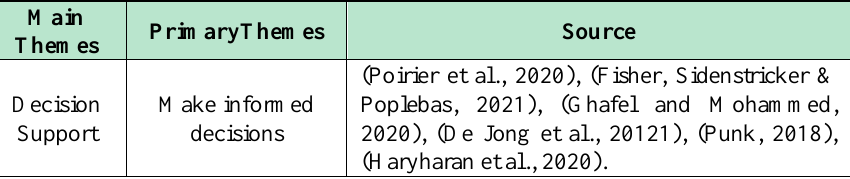
Table 5 - Decision